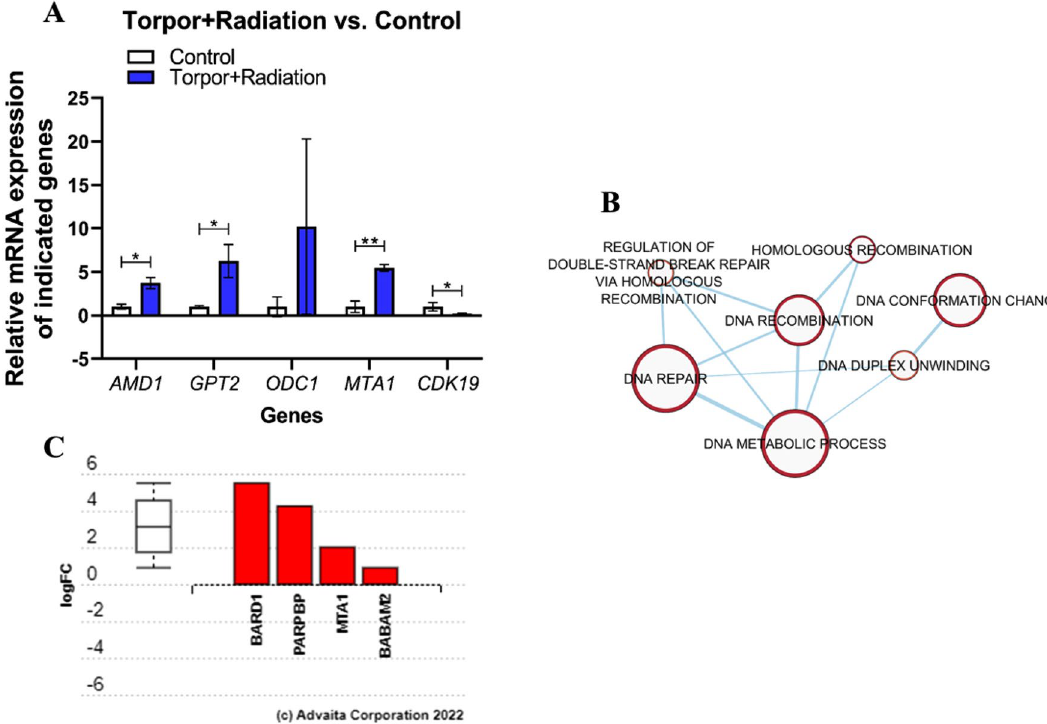
Figure 3. ( A ) Gene expression in the induced torpor + radiation (18.5-mel-rad) group compared to that in the control (28.5-Ctrl) group. The figure shows the relative increase in AMD1 ( p = 0.012), GTP1 ( p = 0.034), ODC1 ( p = 0.309), and MTA1 ( p = 0.0022) expression compared to the control. ODC1 shows a trend towards increased expression in the torpor + radiation group vs control (28.5-Ctrl). CDK19 shows decreased expression compared to the control group ( p = 0.05) * p ≤ 0.05 and ** ≤ 0.01. ( B ) Enrichment map showing that genes related to DNA repair-related biological processes such as homologous recombination are upregulated relative to the control group. ( C ) Bar plot showing differential expression of DNA repair process genes in induced torpor + radiation vs control. BARD1 and PARPBP show strong upregulation in the induced torpor + radiation of the temperature + radiation group (Supplementary Table S18)( q ≤ 0.4), with the radiation group ( q ≤ 0.1)(18.5- rad vs 28.5-rad) to find temperature-mediated effects. The comparison found 390 DEGs unique to the tem- perature + radiation group taken to reflect the effects of temperature (Supplementary Table S19). The ORA of the 215 upregulated DEGs in this group indicates that the temperature was leading to the changes observed in mitosis and the cell cycle (GO: 0000280, GO: 1903047) (Table S18). Downregulated genes suggest temperature dependent changes in the TCA cycle (1,270,121), mitochondrial-related genes (GO: 0098798, GO: 0005743), and translational GO terms (M14691) as expected (Table S20). We next sought to dissect the effects of melatonin from the model through a gene-wise comparison, per- formed with the DEGs in the temperature + melatonin-radiation group and the temperature + radiation group (18.5-mel-rad vs 18.5-rad) (q ≤ 0.4), focusing on those that were found to be unique to the 18.5-mel-rad group after comparison (Supplementary Table S21). ORA results from the 161 DEGs unique to the temperature + mel- atonin-radiation group were further filtered by comparisons with ORA results from the radiation group and those defined as temperature-driven changes (temperature + radiation vs radiation, Table S20) (Supplementary Table S22). Thus, it’s considered that melatonin is leading to increased acetyl-CoA metabolism (GO: 0006637), nucleoside monophosphate metabolism (GO: 0009162), axon regeneration (GO: 0031103), and spindle organisa- tion (GO: 0051294). Downregulated genes were involved in DNA damage checkpoints (GO: 2000003), midbrain morphogenesis (GO: 1904693), the negative regulation of T cell proliferation/morphogenesis (GO: 0045620), and tight junctions (GO: 0061689). Phenotypic end point analysis. Behavioural studies of zebrafish acclimated at 18 °C have previously found a decrease in locomotion 54 . This was supported in our previous work showing that acclimation at 18 °C with the addition of melatonin also led to reductions in locomotion as determined by activity scores in com- parison to control groups 37 . These activity scores were generated by tracking the active swimming time, velocity, and time spent by the zebrafish at the bottom or the upper part of the beaker where higher activity scores rep- resent a more balanced use of space, with more frequent movement between the bottom and upper part of the beaker, whereas lower activity scores indicate less movement and more time sent at the bottom of the beaker. We performed a phenotypic end-point analysis by determining the correlation of activity score and DEGs in both the radiation and torpor + radiation groups. First, normality tests of the rlogged DEGs in the radiation group